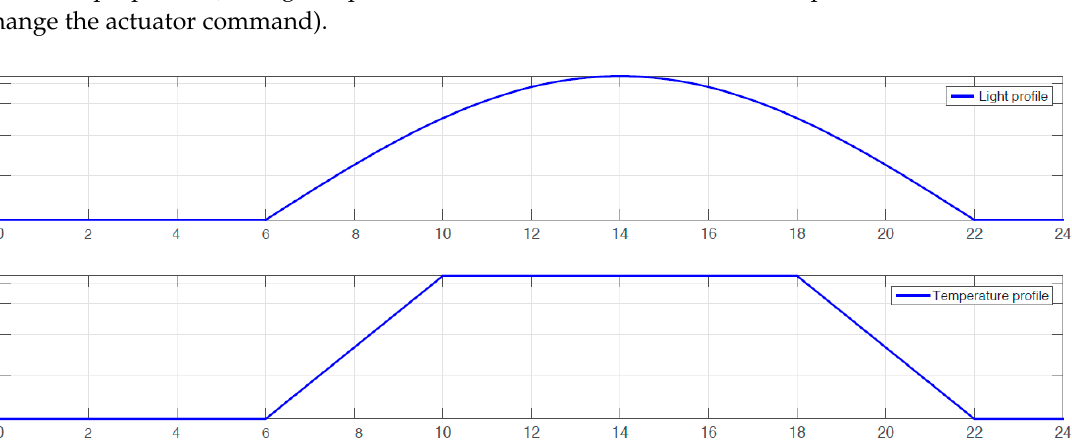
Figure 19. Example of light and temperature profiles specified for a 24 h cycle.